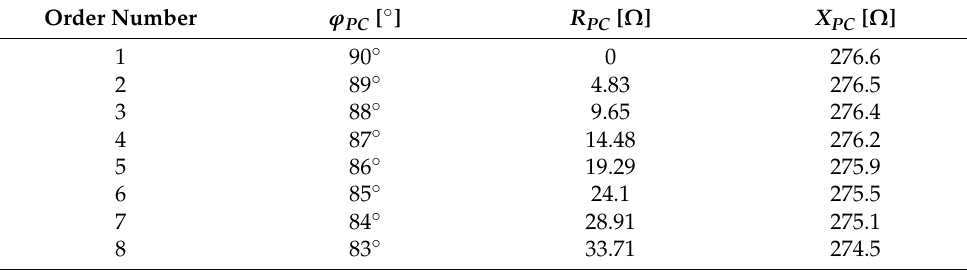
Table 4. Petersen coil parameters depending on the phase shift between u PC and i PC .